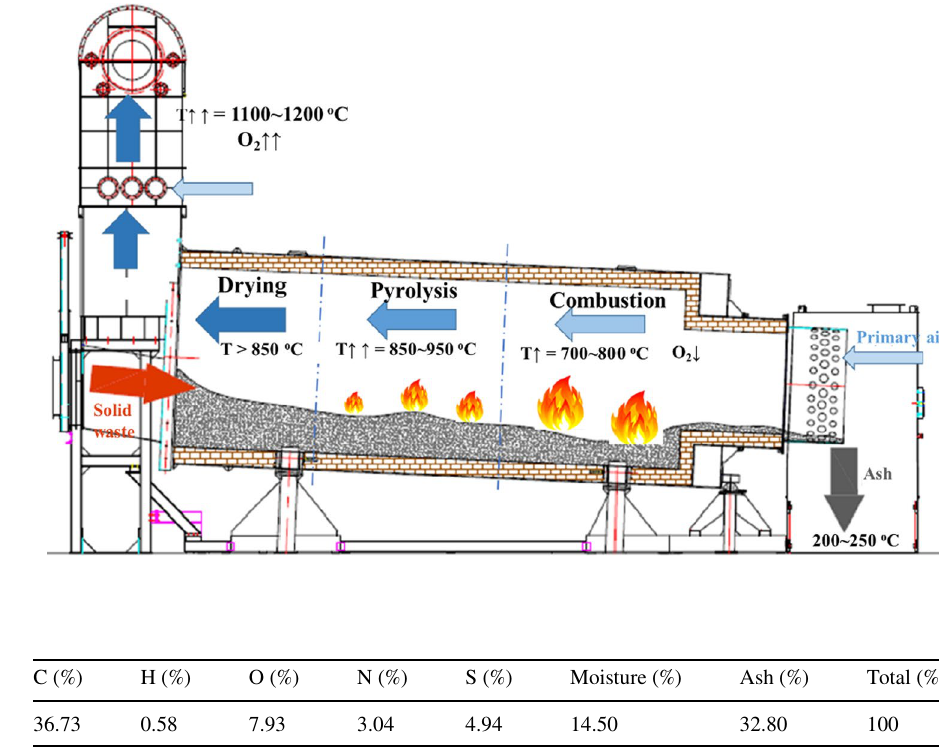
Fig. 1 Schematic diagram of the